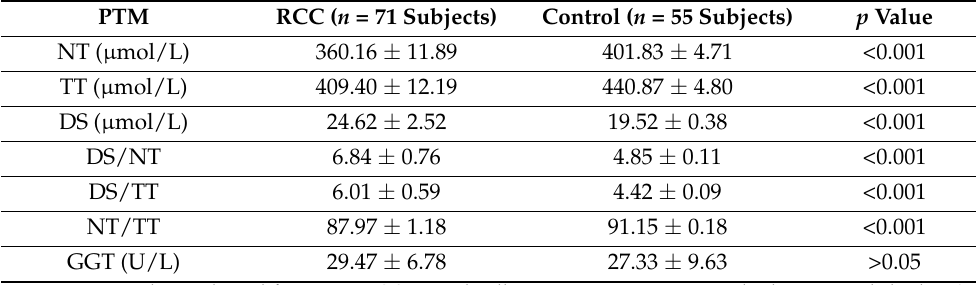
Table 3. Thiol-disulfide homeostasis in the studied groups.